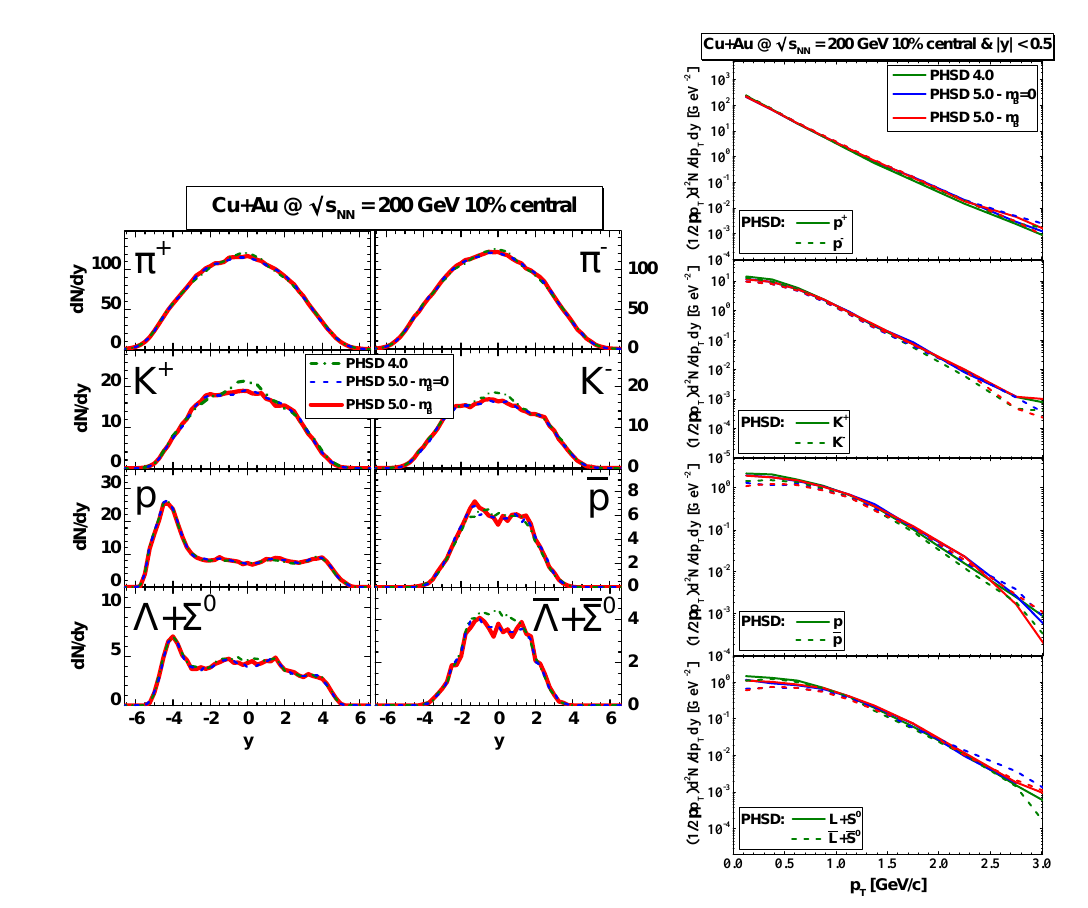
Figure 4. The rapidity distributions (left plot) and p T -spectra at midrapidity ( | y | < 0.5) (right plot) for √ s NN = 200 GeV for PHSD4.0 (green π ± , K ± , p , ¯ p , Λ + Σ 0 , ¯ Λ + ¯ Σ 0 for 10% central Cu+Au collisions at dot-dashed lines), PHSD5.0 with partonic cross sections and parton masses calculated for µ B = 0 (blue dashed lines) and with cross sections and parton masses evaluated at the actual chemical potential µ B in each individual space-time cell (red